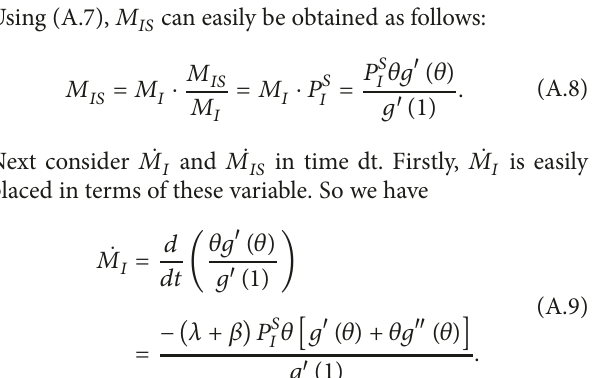
degree 𝑘 , and the third in any